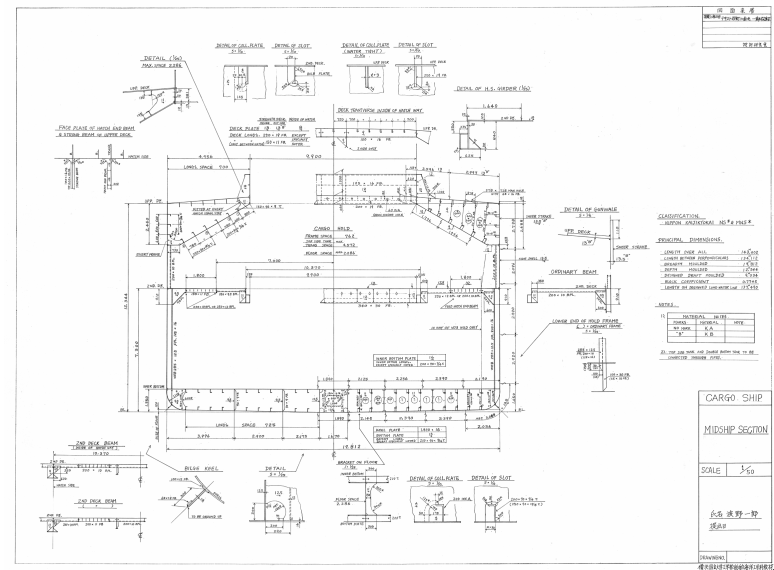
Figure 7. The Midship Section Design.